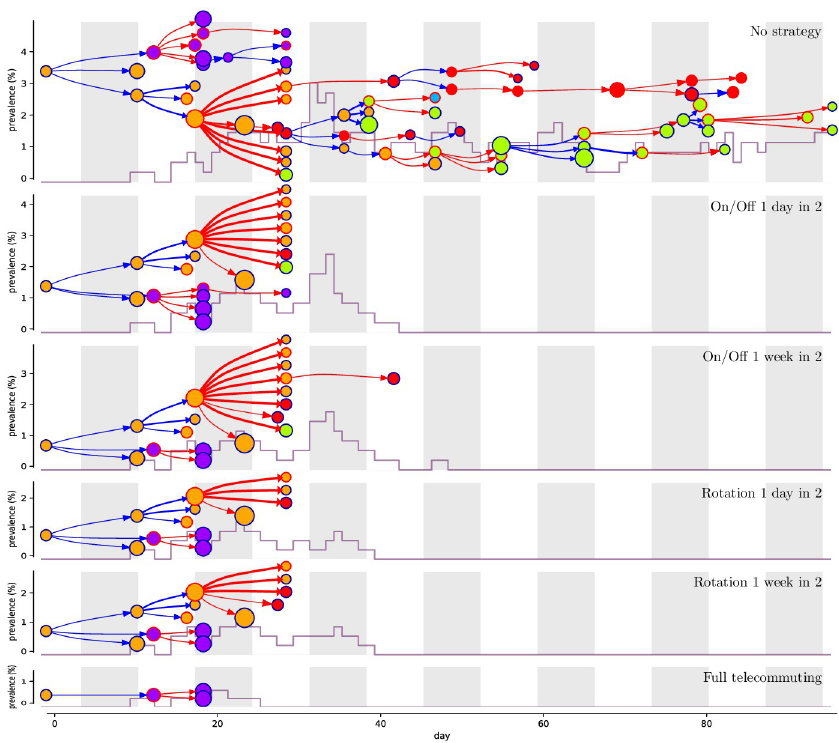
Fig 5. Epidemic propagation in the high school contact graph for different strategies. Each panel corresponds to an example simulation for a given strategy; strategies are sorted as by their effectiveness, from no strategy to full telecommuting. In each panel, the horizontal axis corresponds to time (day of infection) and each white or gray column corresponds to one week. The vertical axis shows the prevalence (percentage of infectious persons among the students), its evolution is plotted in grey. The epidemic propagation is shown as a tree, where each node represents an infected person and points to the persons it infects. Nodes corresponding to symptomatic (resp. asymptomatic) persons are circled in blue (resp. red). Similarly a blue (resp. red) arrow corresponds to a contamination by a symptomatic (resp. asymptomatic) person. The thickness of arrows indicates the super-spreading factor. The node color corresponds to the group of the person (class or department). The node size is linear in its degree in the graph. All the propagation trees are generated using the same realizations of the probabilistic events (run 15978 in our simulations), so that the differences between the trees are not artifacts of their randomness, but solely depend on the different strategies in place.